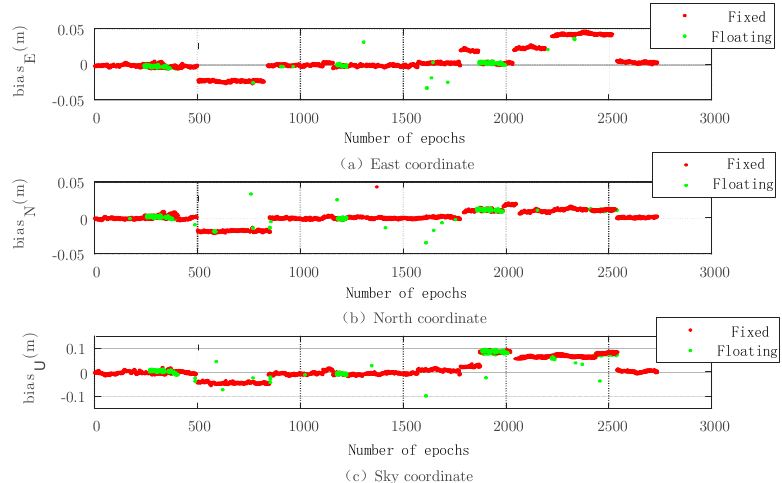
Figure 7. Three − dimensional baseline solution results of conventional PAR algorithm based on the LAMBDA algorithm.